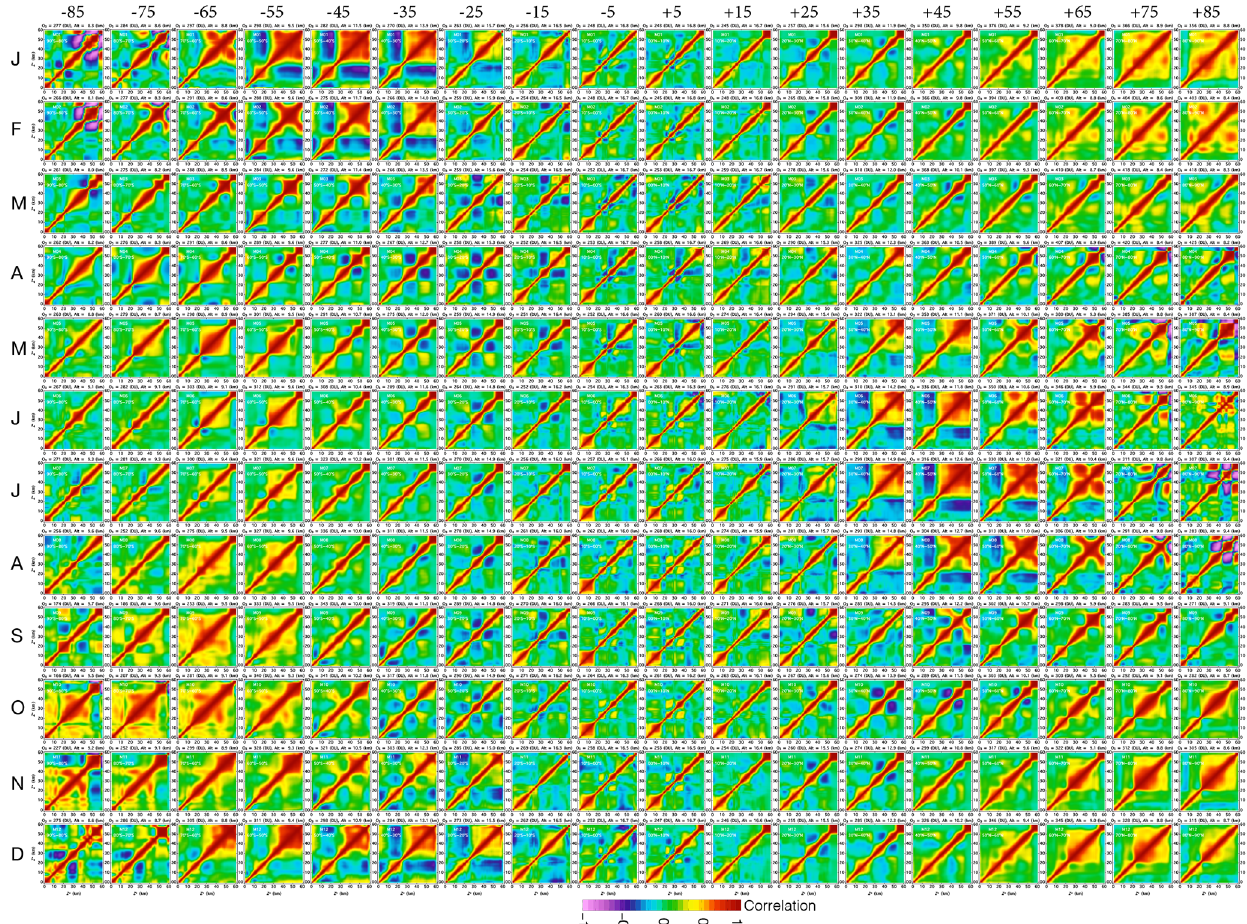
Figure A5. O 3 profile correlation matrices corresponding to daytime monthly zonal mean profiles. The correlation matrices are standardized or normalized covariance matrices (with 1s in the main